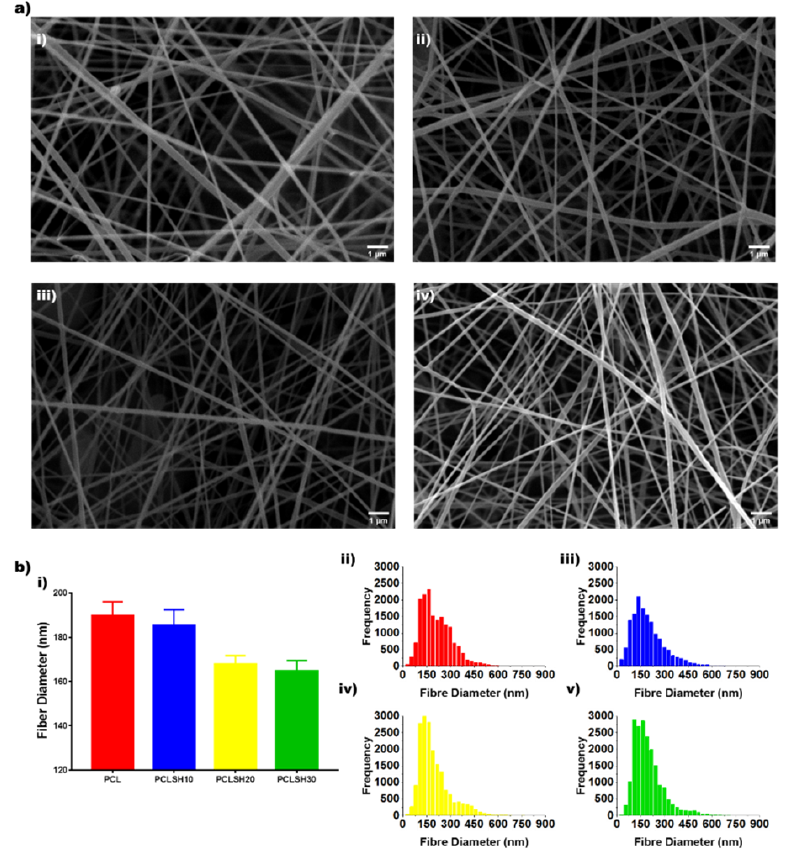
Figure 1. ( a ) SEM images of electrospun meshes: ( i ) PCL, ( ii ) PCLSH10, ( iii ) PCLSH20, and ( iv ) PCLSH30 (scale = 1 µ m). ( b ) ( i ) Mean fiber diameter and distribution of fiber diameters for ( ii ) PCL, ( iii ) PCLSH10, ( iv ) PCLSH20, and ( v ) PCLSH30